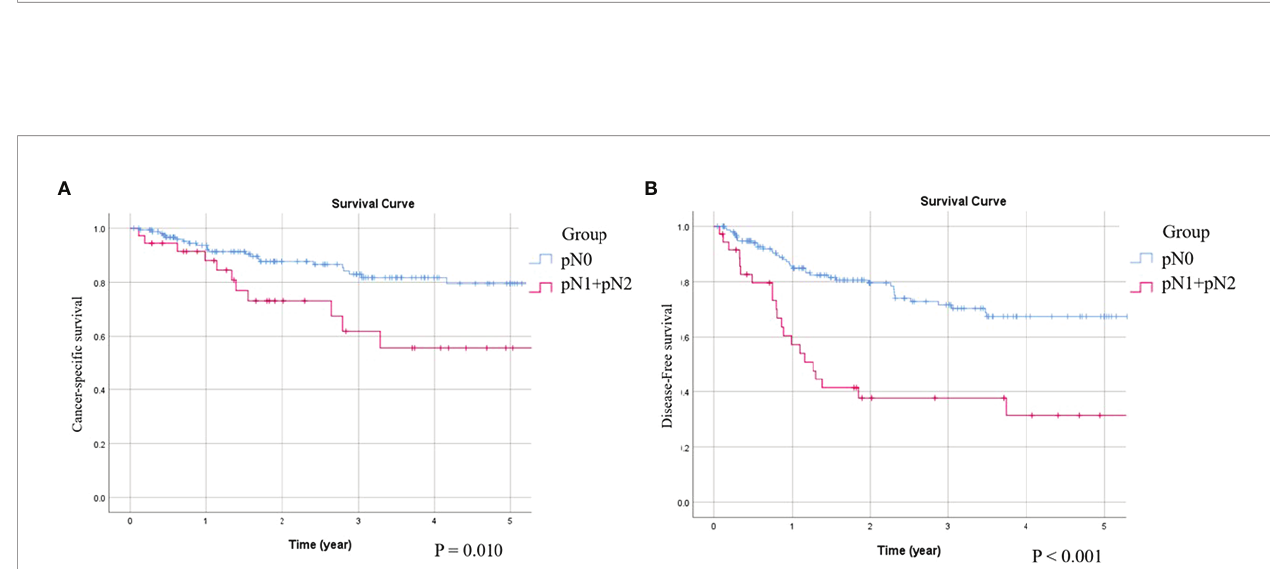
FIGURE 3 | Compare Kaplan-Meier curves in LND (+) group between patients with pN0 and pN1+pN2 by log-rank test. (A) Cancer-speci fi c survival, p = 0.010. (B) Disease-free Survival, p <